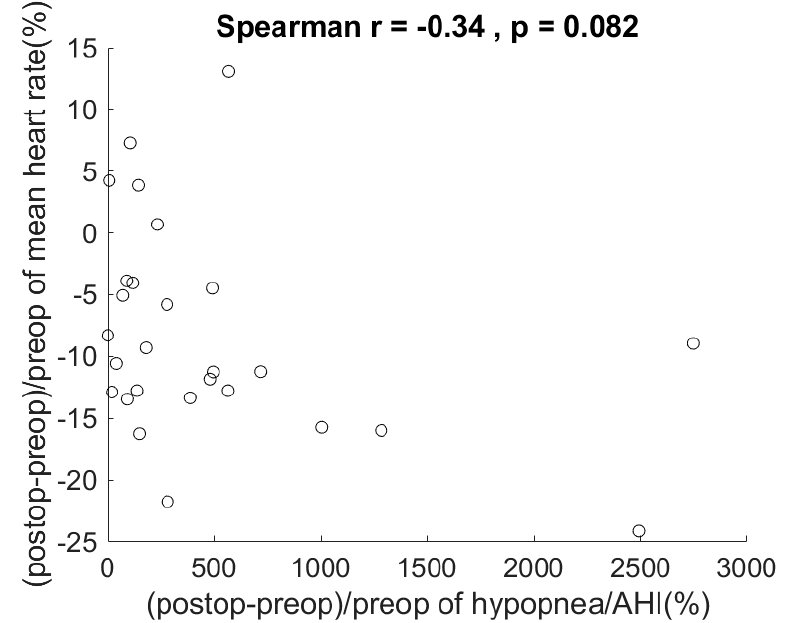
Figure 5. Scatter plot and correlation of proportion change in hypopnea/AHI (defined here as (postoperative–preoperative)/preoperative fraction of hypopnea in AHI) vs. change in mean heart rate (defined here as (postoperative–preoperative)/preoperative mean heart rate). This shows that the change in mean heart rate was not related to the proportion change in hypopnea/AHI.